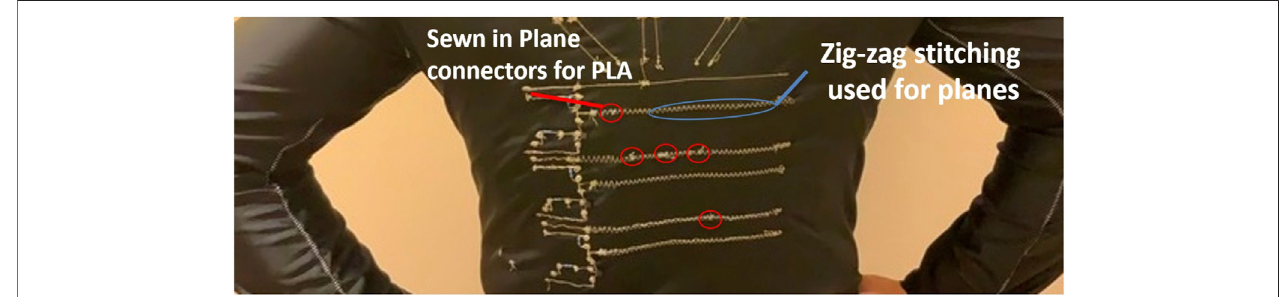
FIGURE 5 | Zigzag wired bus stitching plane for the single-layered design.